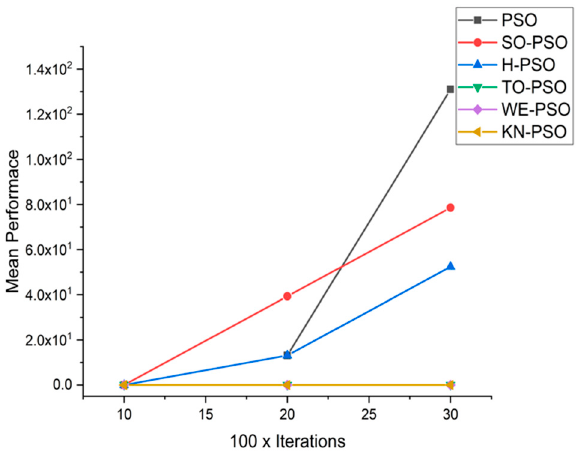
Figure 11. Convergence curve on fn5.